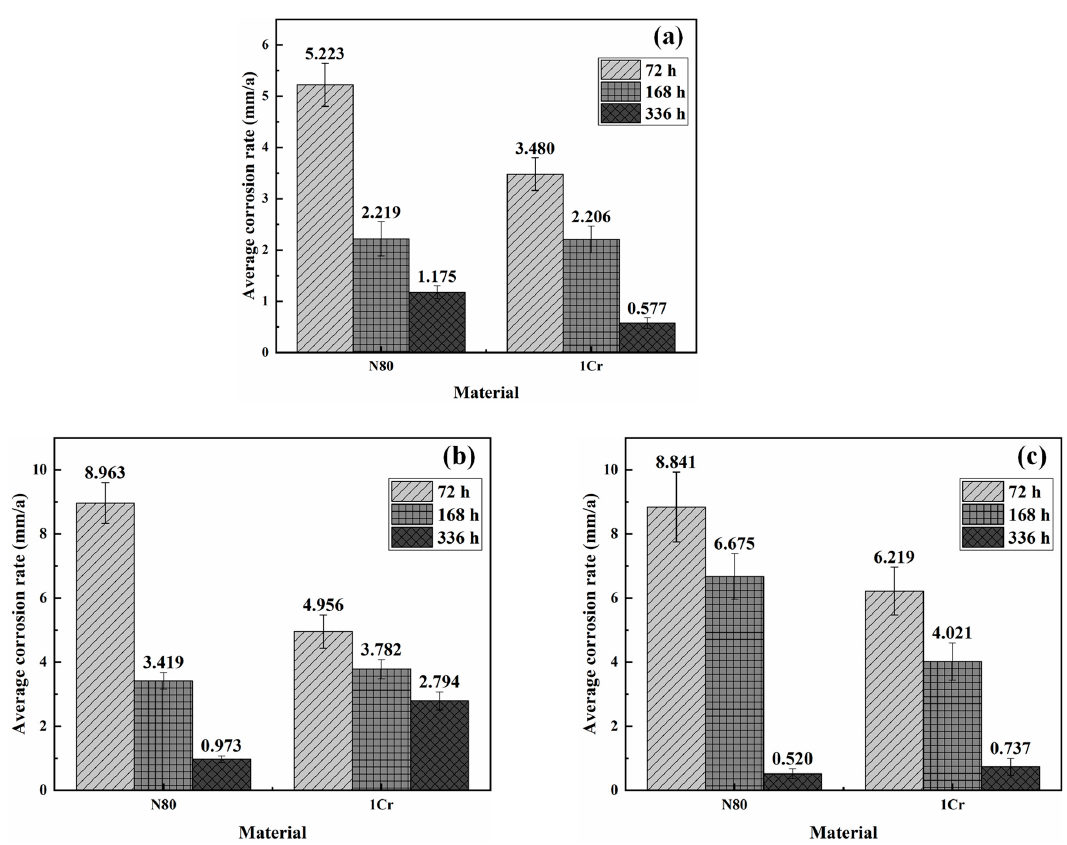
Figure 2. Average corrosion rates of 72 h/168 h/336 h under three corrosion conditions: ( a ) 50 °C-CO 2 : 0.30 MPa, ( b ) 100 °C-CO 2 : 0.63 MPa, ( c ) 114 °C-CO 2 : 0.73 MPa.